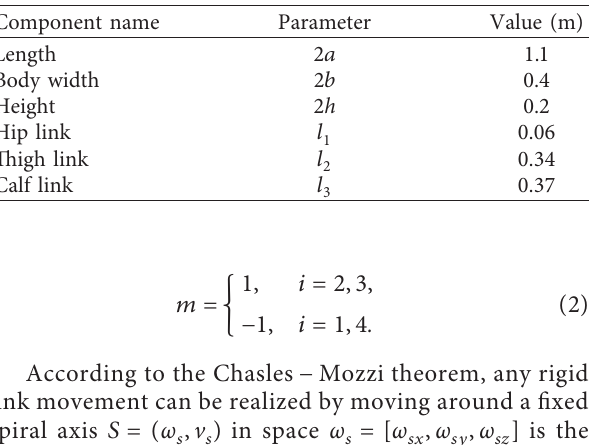
Table 1: Calculation parameter.